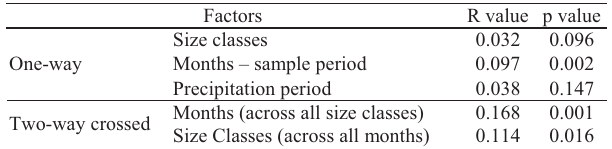
Table 2. Results of the One-way and Two-way Crossed ANOSIM.